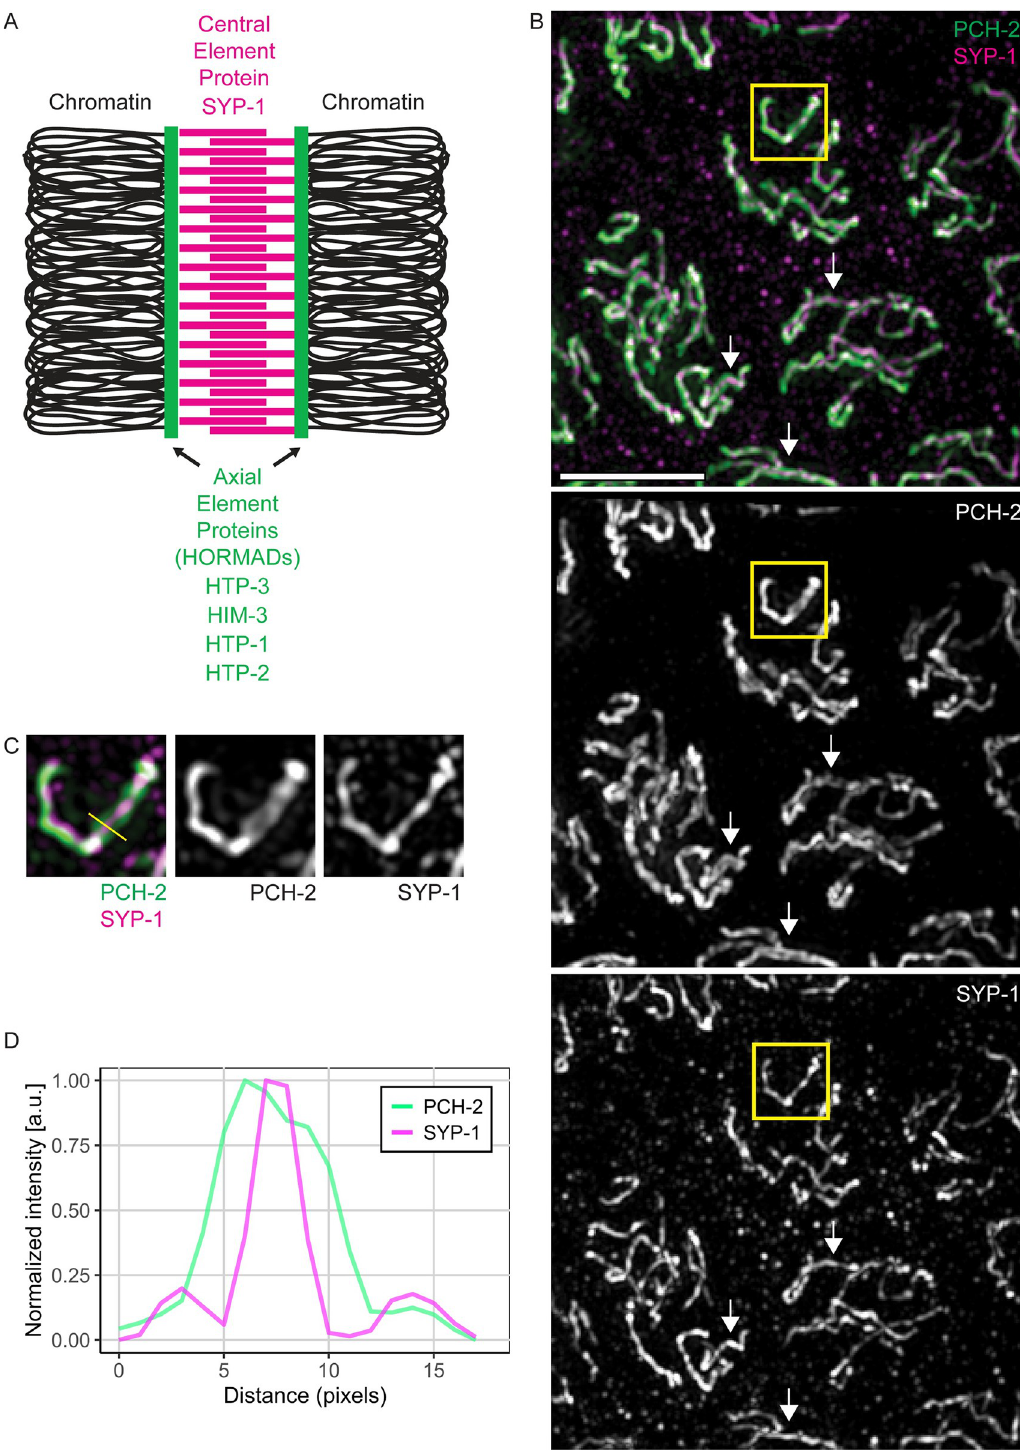
Fig 1. PCH-2’s localization is consistent with remodeling HORMADs on meiotic axes. A. Cartoon of synaptonemal complex with axial elements made up of meiotic HORMADs and the central element component, SYP-1. B. Structured illumination microscopy (SIM) images of meiotic nuclei stained with antibodies against PCH-2 (green) and SYP-1 (magenta). Arrows represent regions of PCH-2 potentially associated with meiotic axes. Scalebar indicates 5 microns. C. Cropped insets of PCH-2 and SYP-1 signal. Yellow line represents area of pixel intensities measured. D . Line scans of PCH-2 (green) and SYP-1 (magenta) pixel intensities plotted against distance in pixels.